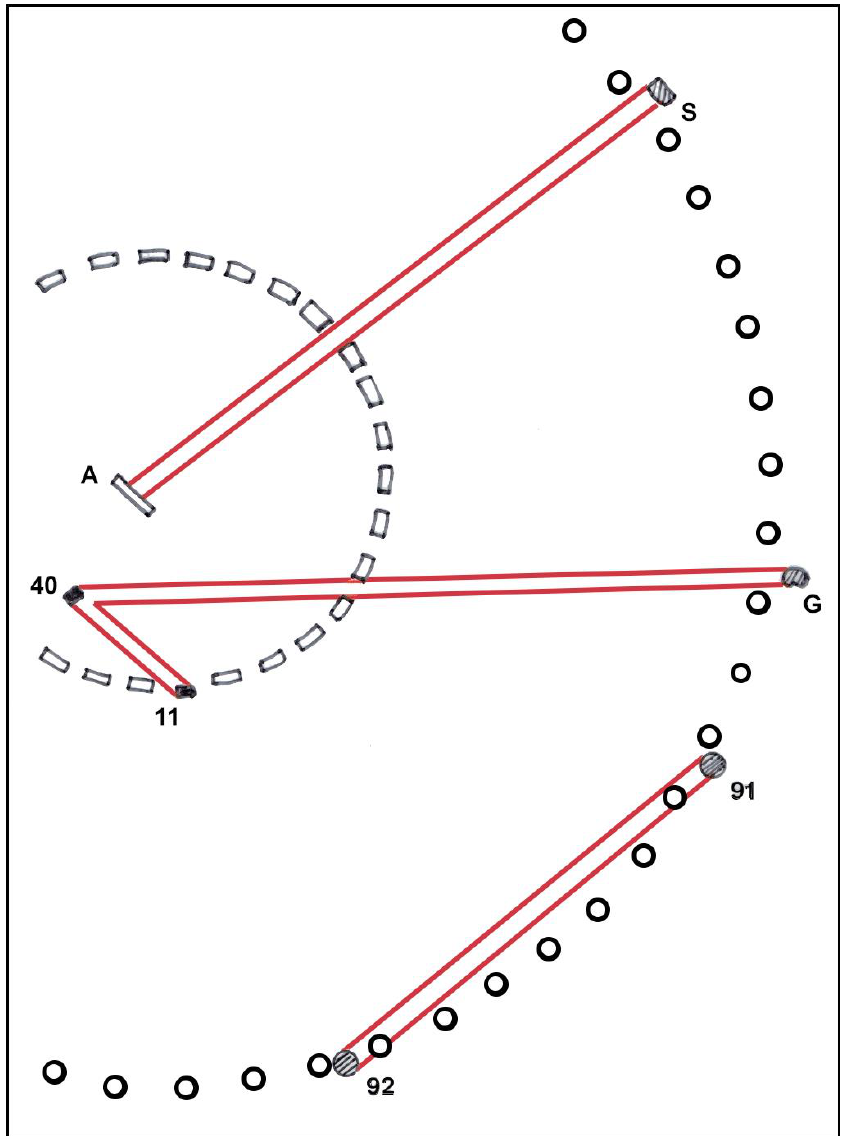
Figure 14. The plan shows the positions of seven stones or stone-holes and arcs of the Aubrey Hole circle and sarsen circle. The long axis of the Altar Stone A is towards the winter solstice sunrise, and is not, as explained in Section 4.2, exactly perpendicular to the Avenue and the summer solstice sunrise. Included is the line of shadow cast by Slaughter Stone S when standing. Additionally, the plan shows how a shadow from the short round- topped Stone 11 would fall upon the ignimbrite Stone 40/38 at midwinter sunrise and how a shadow from a stone at Hole G would cast an equinoctial shadow upon the same stone (refer to text in Section 4.2). The two Station Stones, 91 and 92, that relate to the direction of the winter solstice sunset and midsummer sunrise are included too. The same would apply to Station Stones 93 and 94 (not shown). (Drawn by the